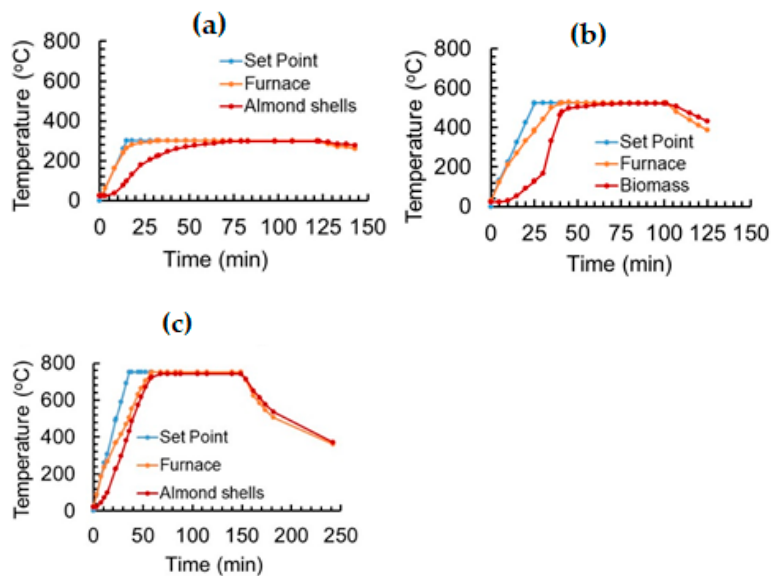
Figure 3. Selected temperature profiles for the furnace cavity and almond shells during laboratory pyrolysis. Samples were allowed to cool in the furnace, under continuous nitrogen purge, following the prescribed hold time at the set point temperature: ( a ) 300 ◦ C for 90 min and MC of 5%; ( b ) 550 ◦ C for 60 min and MC of 10%; and ( c ) 750 ◦ C for 90 min and MC of 5%.